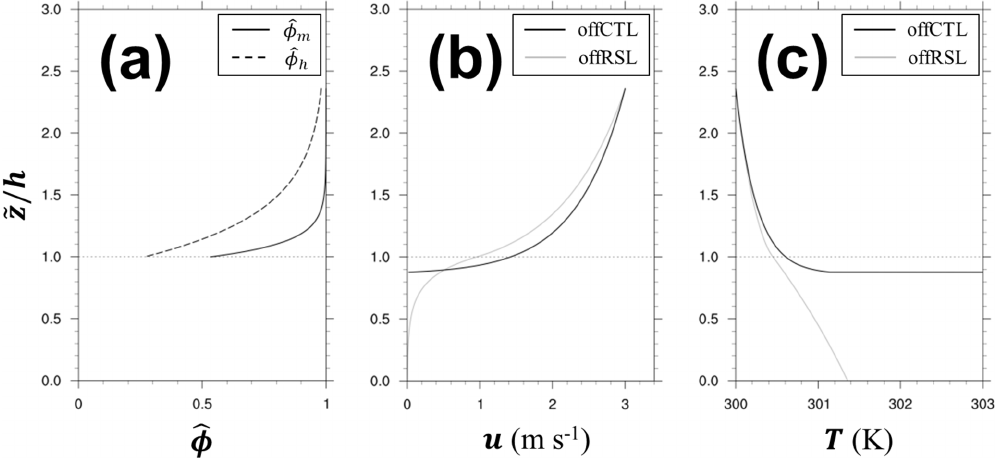
Figure 6. (a) Profiles of the RSL function for momentum ( ˆ φ m , solid line) and heat ( ˆ φ h , dashed line), (b) wind speed (ms − 1 ), and (c) tem- perature (K) at a neutral condition from offCTL (black) and offRSL (gray). The height of conventional coordinate system ( ˜ z ) is normalized by the canopy height ( h